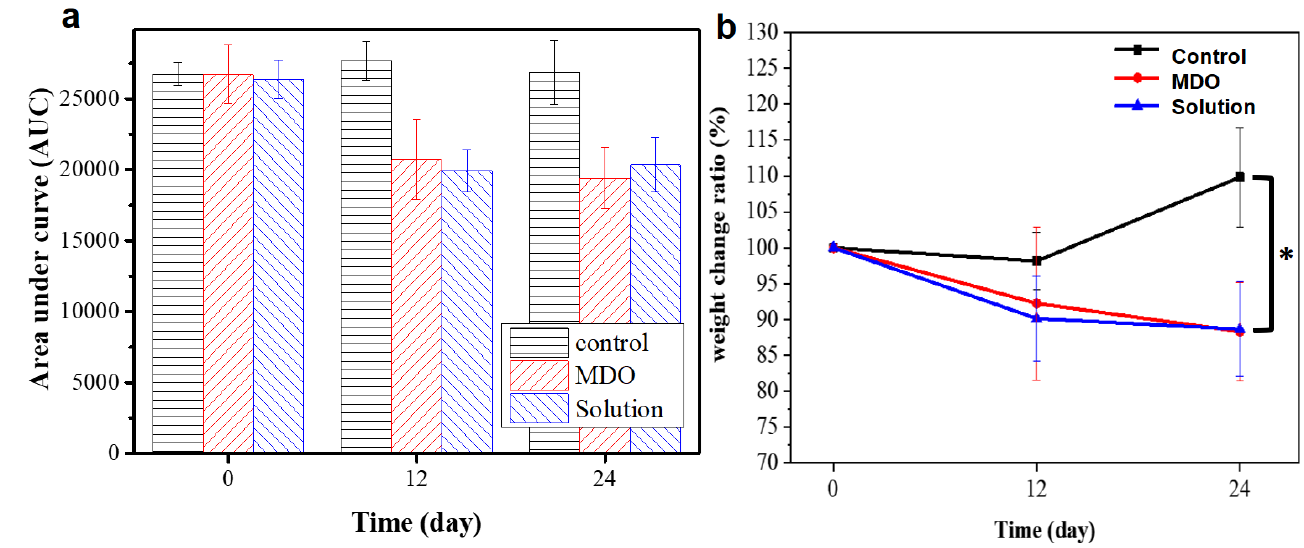
Figure 7. Blood glucose levels ( a ), area under the curve (AUC), and ( b ) weight change rate recorded